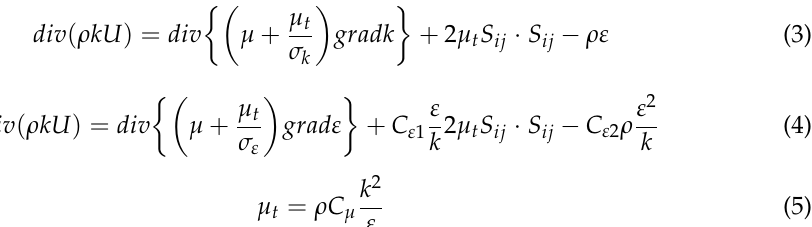
Figure 7. Structure of the ultrafine wire.